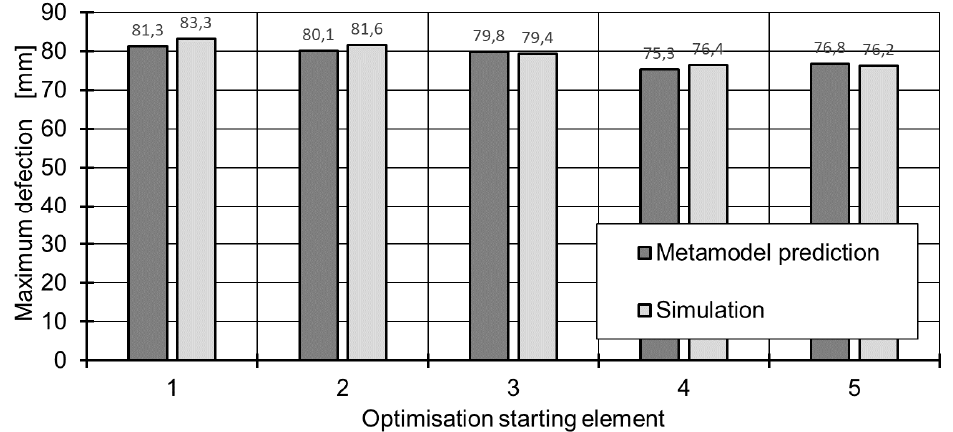
Figure 11. Comparison of deflections obtained by metamodel and FEM for optimised preforms.